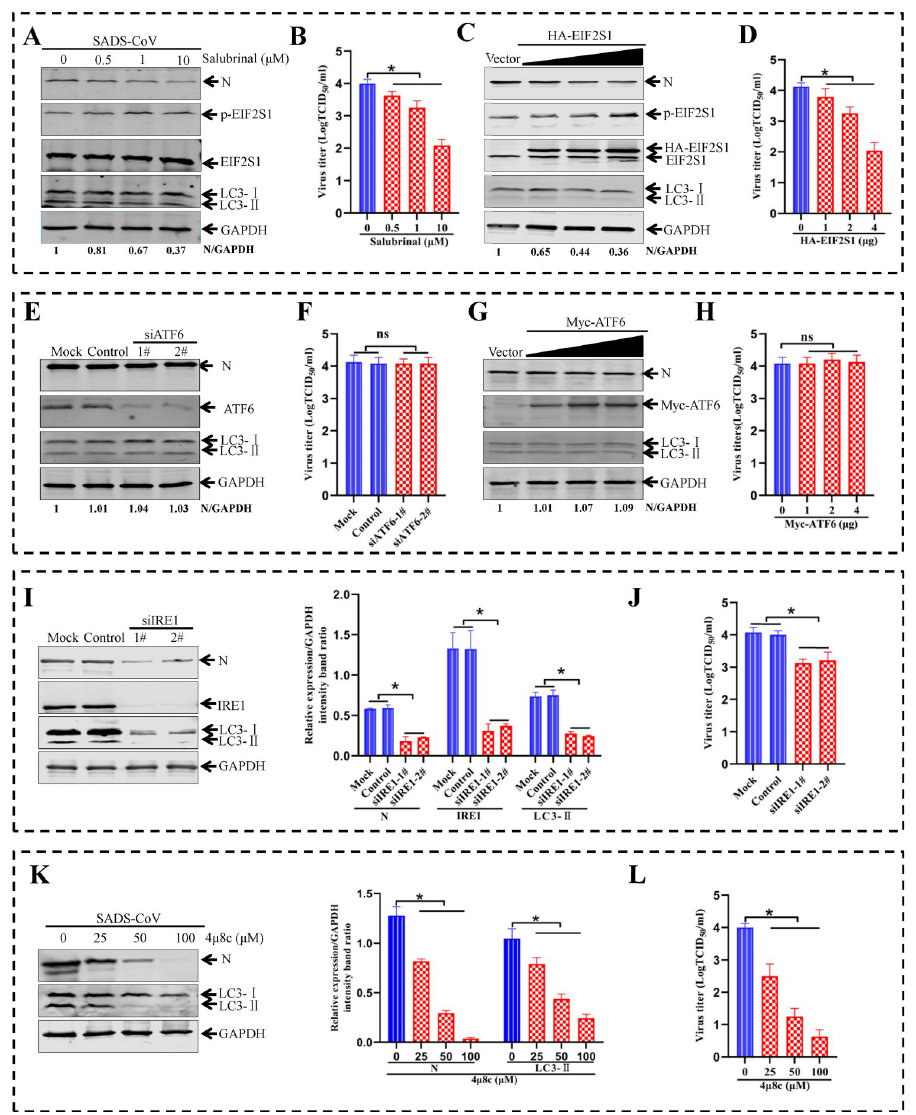
Fig 7. The ER stress sensor IRE1, but not PERK-EIF2S1 and ATF6, is involved in SADS-CoV-induced autophagy and facilitates SADS-CoV replication. ( A and B ) ST cells are treated with the indicated concentrations of salubrinal for 2 h and then infected with SADS-CoV (MOI = 0.1). After the adsorption of viruses to cells, media containing the indicated concentrations of salubrinal is added. Cellular lysates of ST cells are analyzed by western blotting using antibodies against SADS-CoV N protein, p-EIF2S1, EIF2S1, LC3, or GAPDH. The densities of N bands were analyzed to calculate the values relative to that of GAPDH. Results were normalized to group 0 μ m of salubrinal, which were set as 1. The titers of SADS-CoV in the supernatants are determined on Vero E6 cells. ( C and D ) ST cells are transfected with pCAGGS-HA (Vector) or pHA-EIF2S1 for 24 h and then infected with SADS-CoV. At 36 hpi, western blotting is performed to detect levels of SADS-CoV N, p-EIF2S1, EIF2S1, LC3 or GAPDH, and the viral titers are determined. The densities of N bands were analyzed to calculate the values relative to that of GAPDH. Results were normalized to group Vector, which were set as 1. ( E and F ) ST cells treated with Mock, Control siRNA or siATF6 for 48 h are infected with SADS-CoV for 36 h. Western blotting is performed to detect levels of SADS-CoV N, ATF6, LC3, or GAPDH, and the viral titers are determined. The densities of N bands were analyzed to calculate the values relative to that of GAPDH. Results were normalized to mock cells, which were set as 1. (G and H ) ST cells are transfected with pCMV- Myc (Vector) or pCMV-Myc-ATF6 for 24 h and then infected with SADS-CoV. At 36 hpi, western blotting is performed to detect levels of SADS-CoV N, Myc, LC3 or GAPDH, and the viral titers are determined. The densities of N bands were analyzed to calculate the values relative to that of GAPDH. Results were normalized to group Vector, which were set as 1. ( I and J ) ST cells treated with Mock, Control siRNA or siIRE1 for 48 h are infected with SADS- CoV for 36 h. Western blotting is performed to detect levels of SADS-CoV N, IRE1, LC3, or GAPDH, and the